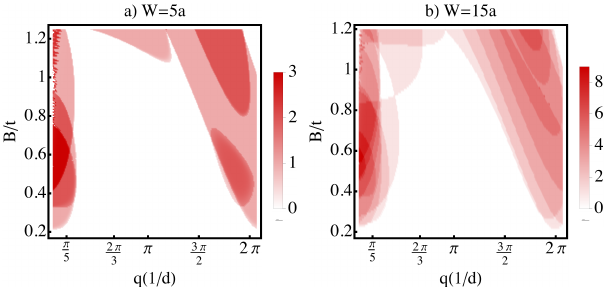
Figure 13: a) Dependence of total MP with the amplitude of the magnetic field B (in units of t ) and q (in units of 2 π/ d ) for Z strips. Use a) W = 5 a and b) W = 15 a strips, with L = 173 a , and ∆ = 0.2